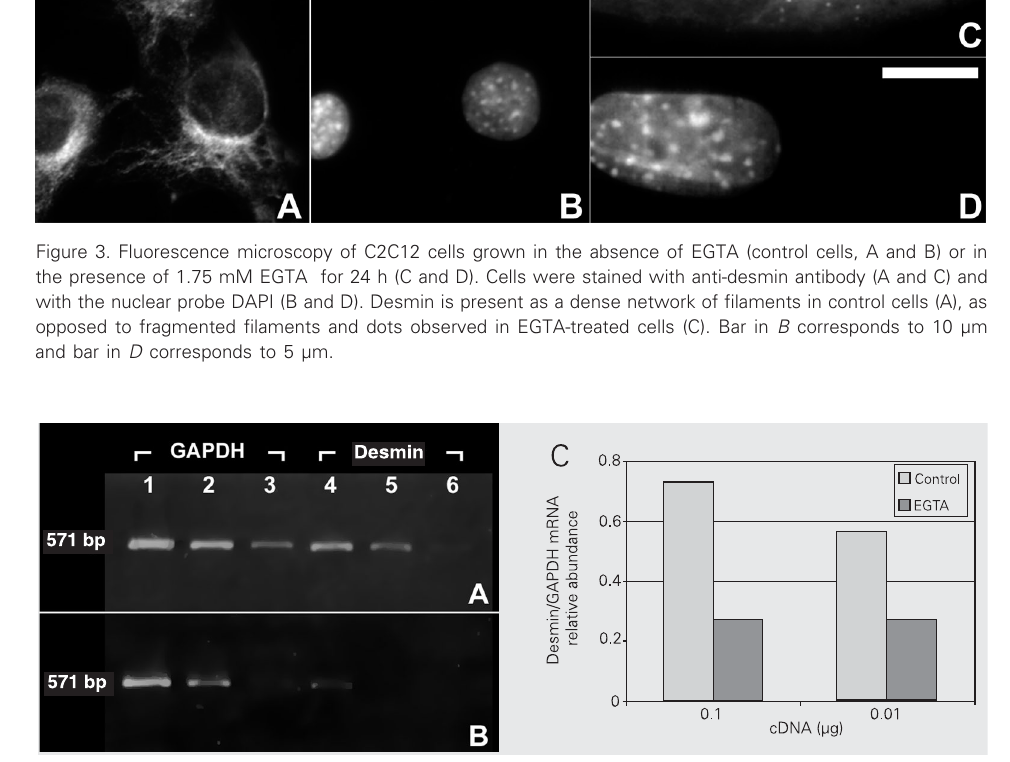
Figure 4. RT-PCR analysis of the expression of desmin in control (A) and in 24-h EGTA-treated C2C12 cells (B). Lanes 1-3 of both agarose gels (A and B) correspond to GAPDH expression (0.1 µg, 0.01 µg, and 0.001 µg cDNA, respectively). Lanes 4-6 of both agarose gels correspond to desmin expression (0.1 µg, 0.01 µg and 0.001 µg cDNA, respectively). C , Comparative expression of desmin in control and EGTA-treated cells after normalization of PCR data (for details, see Material and Methods). GAPDH = glyceraldehyde-3-phosphate